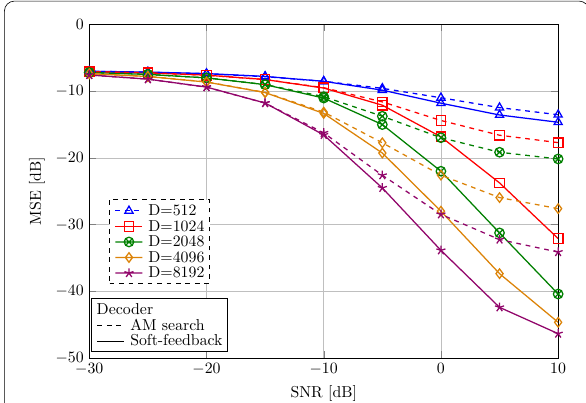
Fig. 14 Mean-squared error (MSE) for reconstructing features from spatially encoded vector x decoded with soft-feedback or with AM readout without feedback